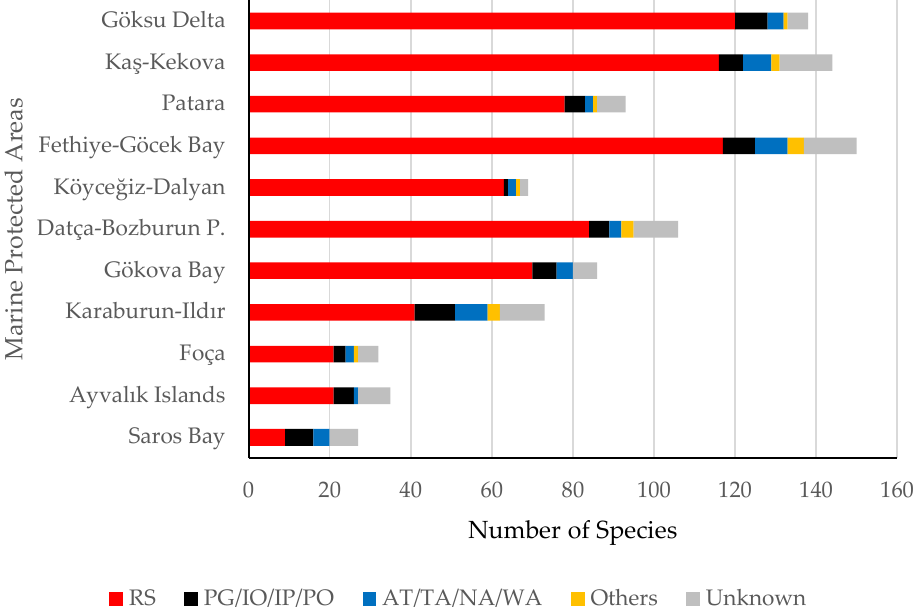
Figure 4. Origins of alien taxa in MPAs. For ease of interpretation, low contributing origins were grouped: red group, RS: Red Sea; black group, PG: Persian Gulf, IO: Indian Ocean, IP: Indo-Pacific, PO: Pacific Ocean; blue group, AT: Atlantic, TA: Tropical Atlantic, NA: North Atlantic, WA: Western Atlantic; yellow group (others), ST: Subtropical Atlantic/Pacific, CT: Circumtropical; grey group, species with currently unknown